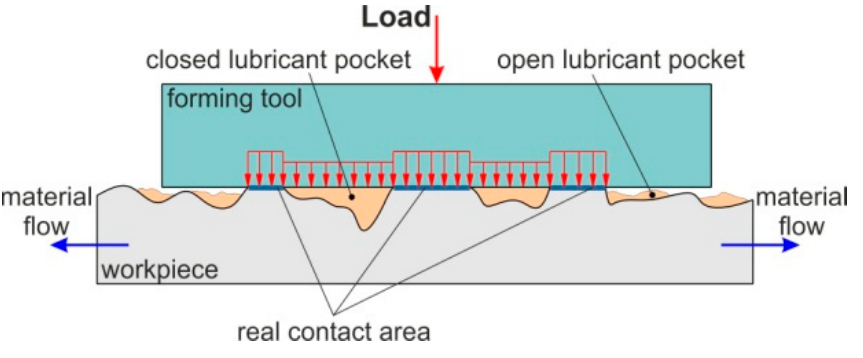
Figure 14. Closed and open lubricant pockets.